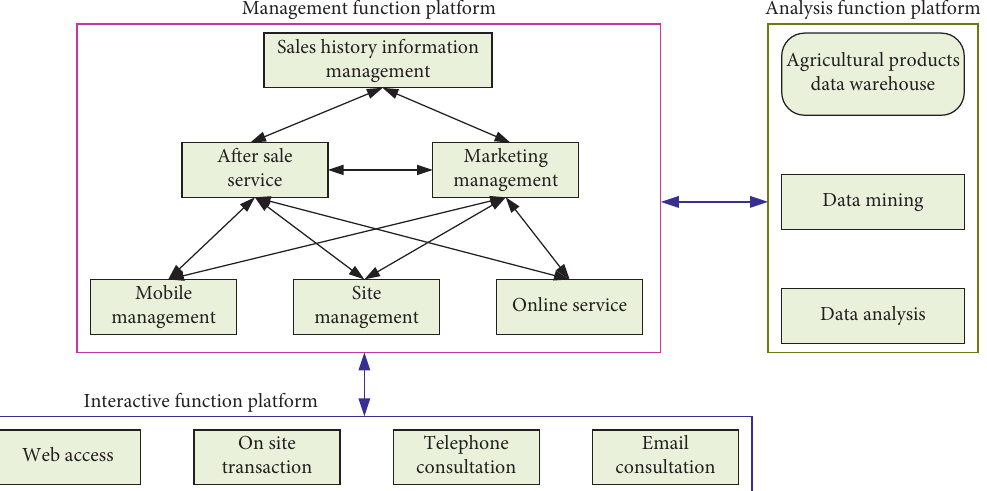
Figure 1: Supply and demand relationship management and the relationship between functional platforms.